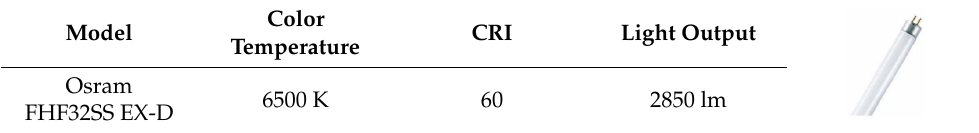
Table 5. Specifications of experimental environment artificial lighting (Osram FHF32SS EX-D).